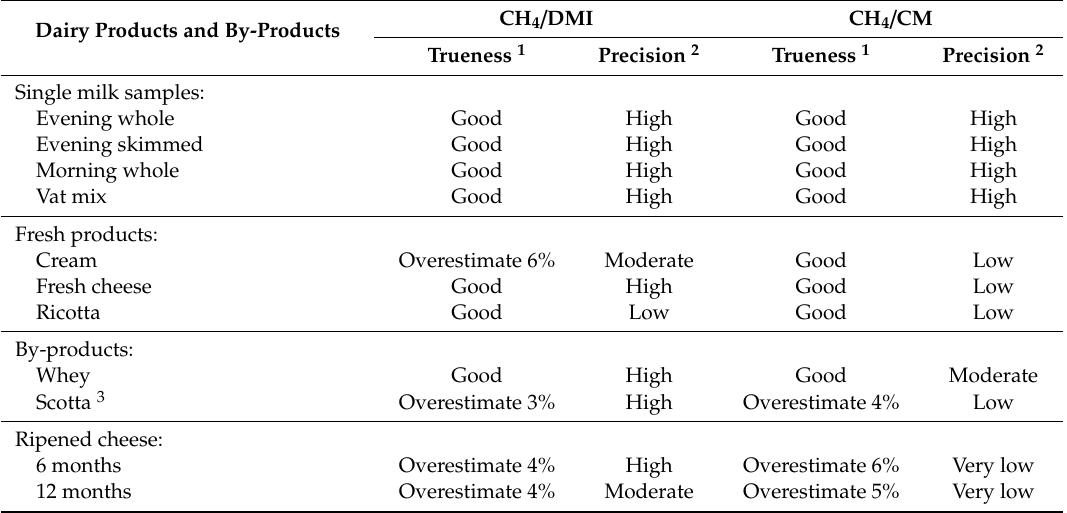
Table 3. Accuracy of the predictions of bovine enteric methane yield (CH 4 / DMI) and enteric methane intensity per kg corrected milk (CH 4 / CM) obtained from the fatty acid profile of alternative sources of information (single milk samplings, and dairy products and by-products) respect to the reference value obtained from fatty acid profile of the average of samplings of unprocessed bovine milk from morning and evening milkings. Accuracy is evaluated in terms of trueness (bias) and precision (error). CH 4 / Dairy Products and By-Products